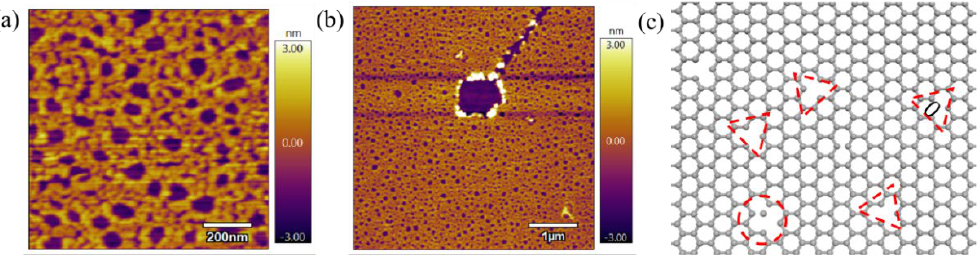
Figure 8. AFM morphology of graphene after long-term UV vacuum irradiation: ( a ) surface micro- scopic defects; ( b ) topography after friction under 40 nN load; ( c ) schematic diagram of defects after UV vacuum irradiation.